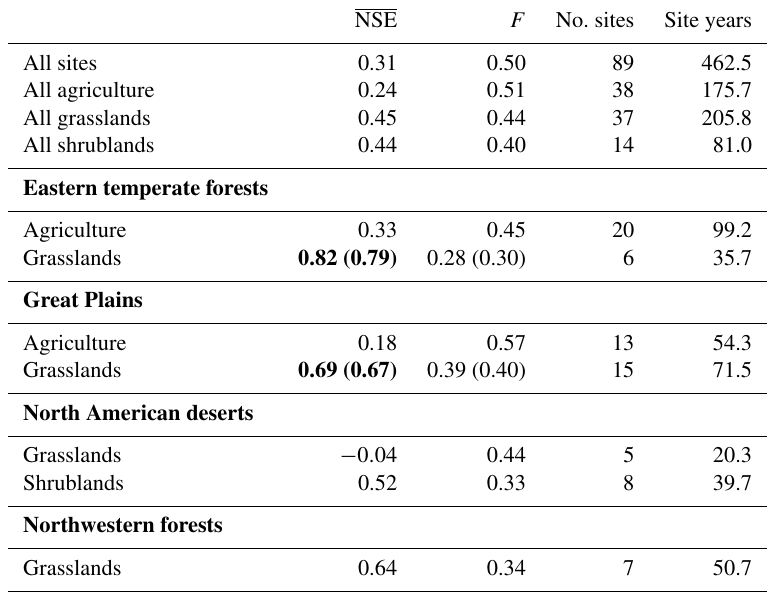
Table 1. Average site-level Nash–Sutcliffe coefficient of efficiency (NSE) and mean coefficient of variation of the mean absolute error ( F ) for each model parameterization. Bold indicates when the NSE was greater than the acceptable threshold of 0.65. Values in parentheses represent the NSE or F in the leave-one-out cross-validation.